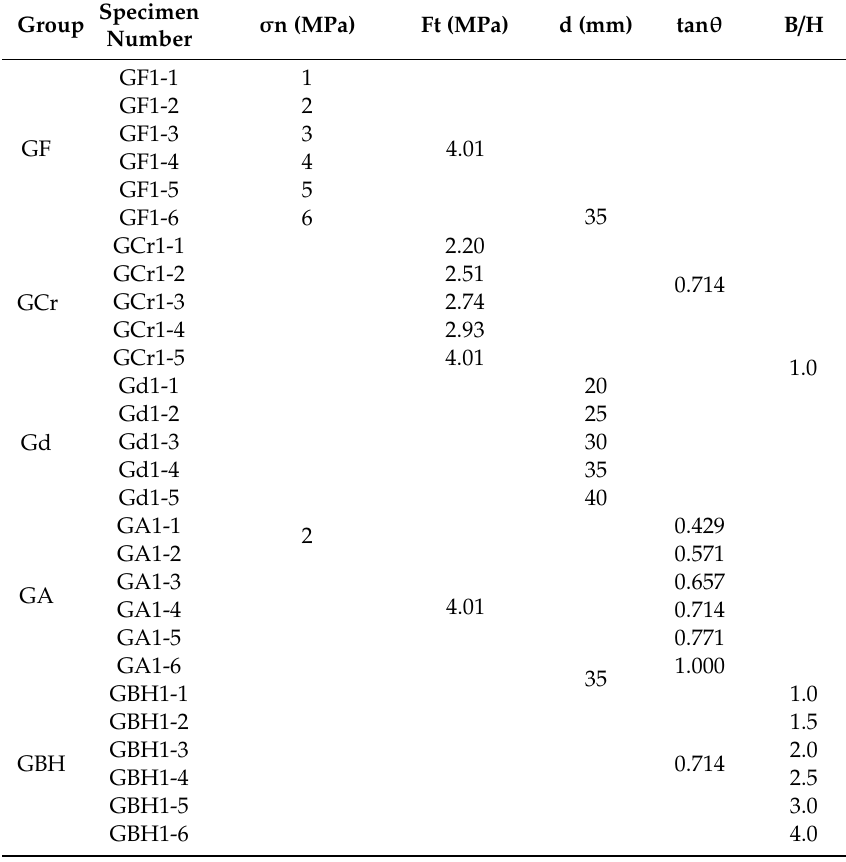
Table 4. Finite element model parameters of the single-keyed dry